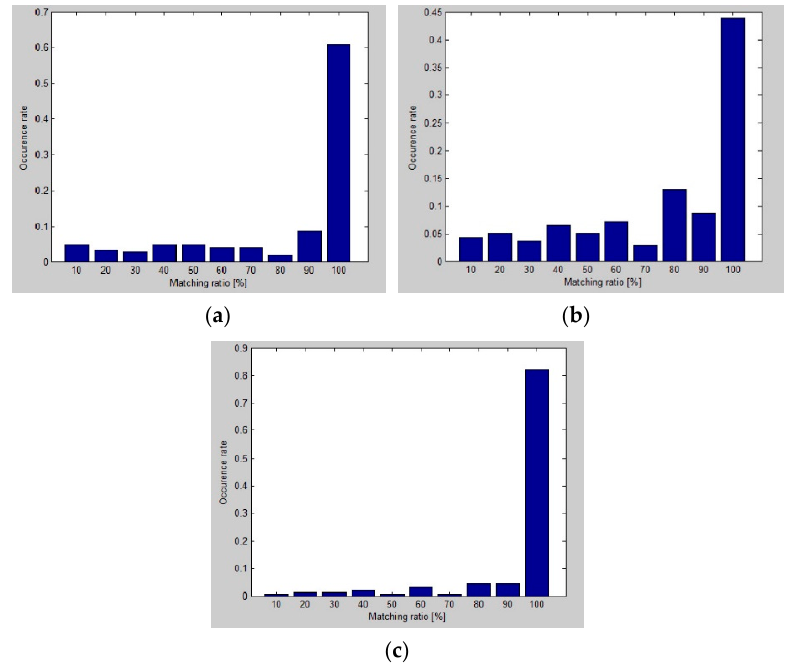
Figure 15. Histograms with matching ratio results for ( a ) location sensors AB; ( b ) location sensors BD ; and ( c ) location sensors AD .